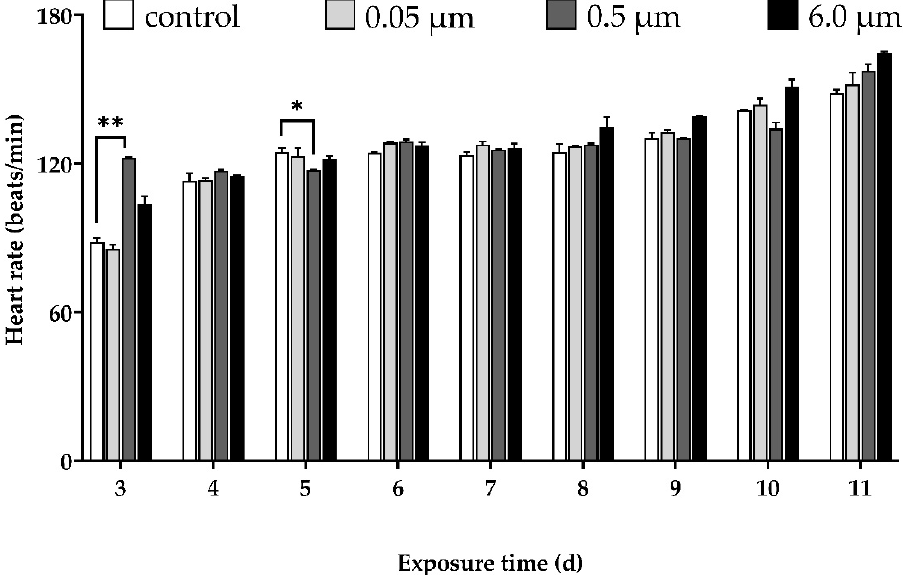
Figure A3. Effects of PS-MPs of different sizes on heart rate of the O. melastigma embryos (n = 9). Asterisks indicate significant difference between the treatment group and the control at each time point (* p < 0.05, ** p < 0.01).